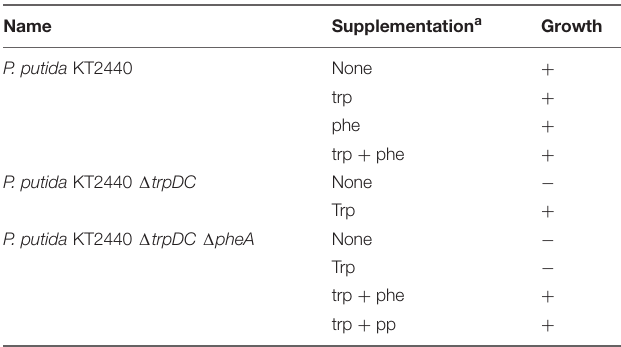
TABLE 3 | Auxotrophy supplementation of P. putida KT2440 (cid:2) trpDC and (cid:2) pheA